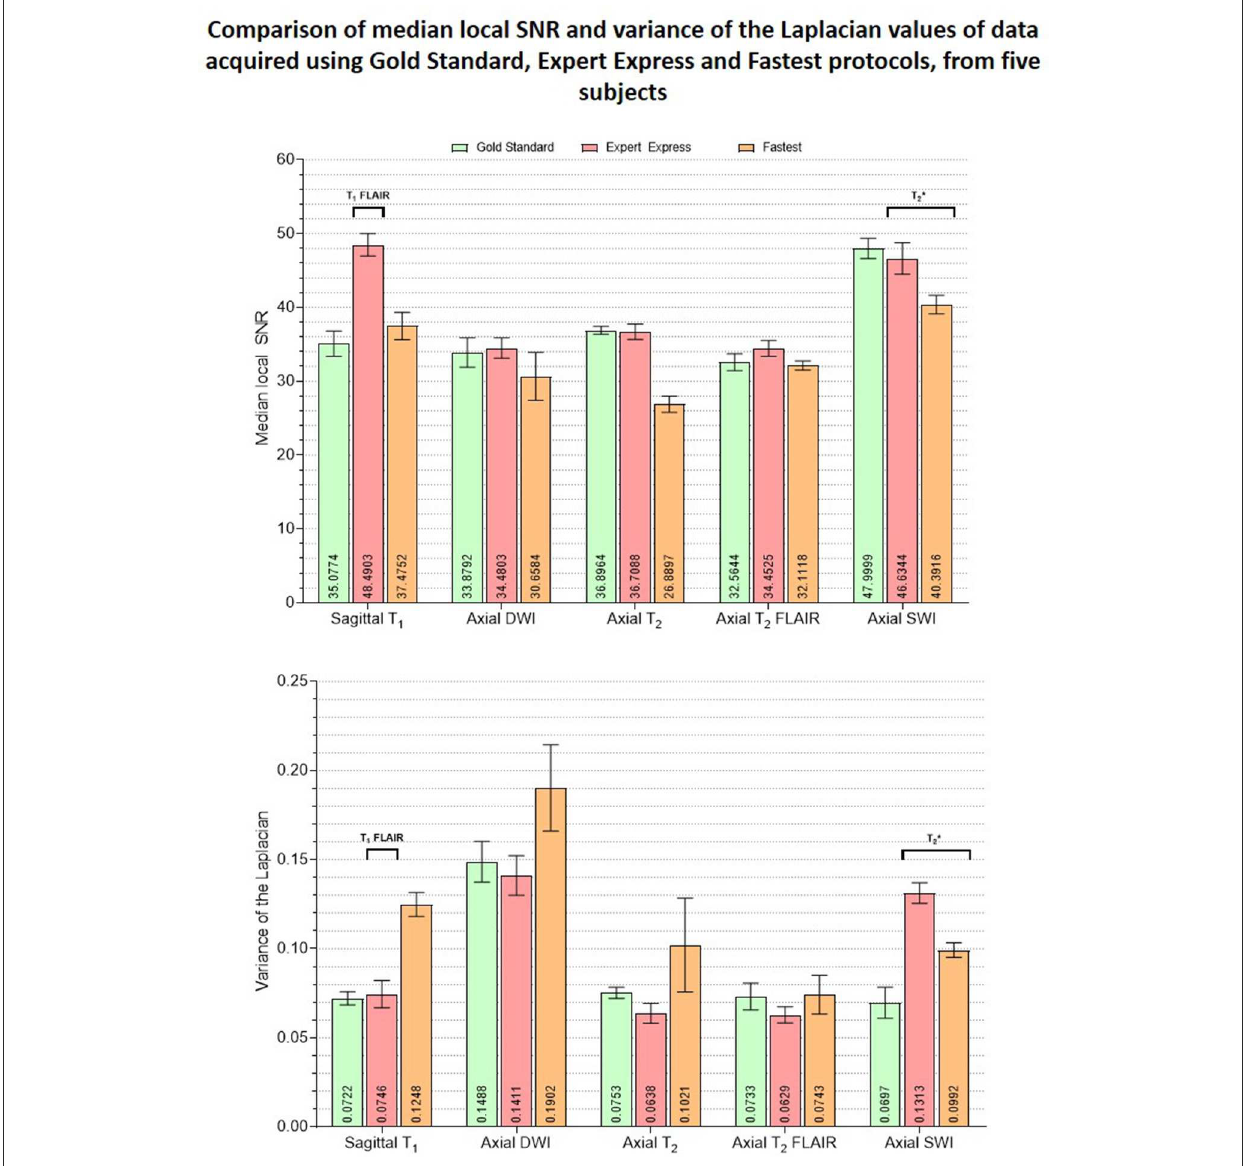
FIGURE8 Plots comparing the median object-masked local SNR and variance of the Laplacian values computed on the GS, EE and Fastest datasets, for matched contrasts. The mean values are presented at the bottom of the individual bars. The EE protocol employed a T1 FLAIR sequence while the GS and Fastest protocols leveraged T1 MPRAGE sequences instead. Similarly, T * 2 sequences are utilized in the EE and Fastest protocols instead of a SWI sequence as in the GS